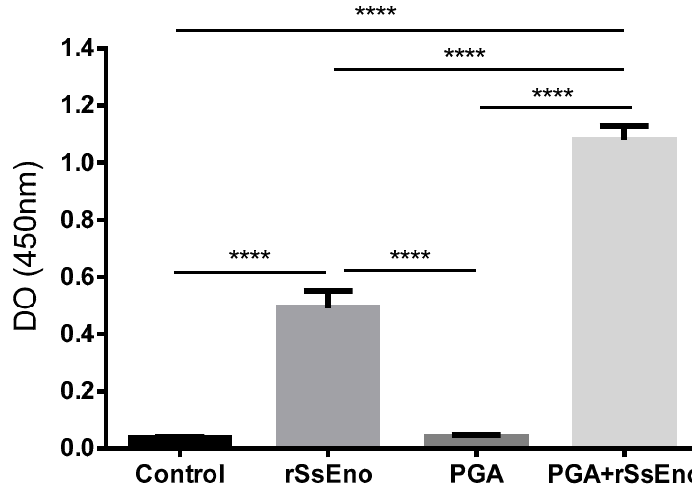
Figure 2. Immunization with PGA+rSsEno markedly enhanced the IgG antibody response to rSsEno. Balb/c mice were immunized (s.c.) twice with rSsEno, PGA, PGA+rSsEno, or PBS as negative control. Serum collected seven days after the second immunization was used to determine rSsEno-specific IgG antibody. **** ( p < 0.0001).